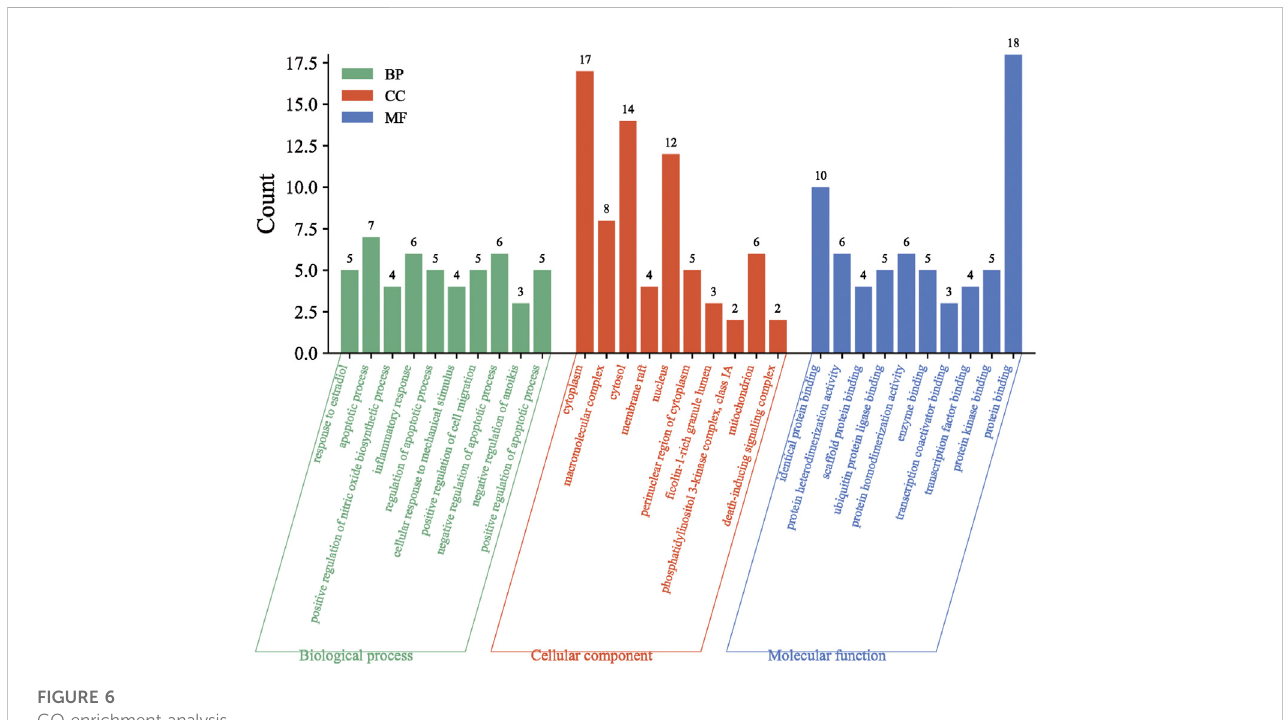
FIGURE 6 GO enrichment